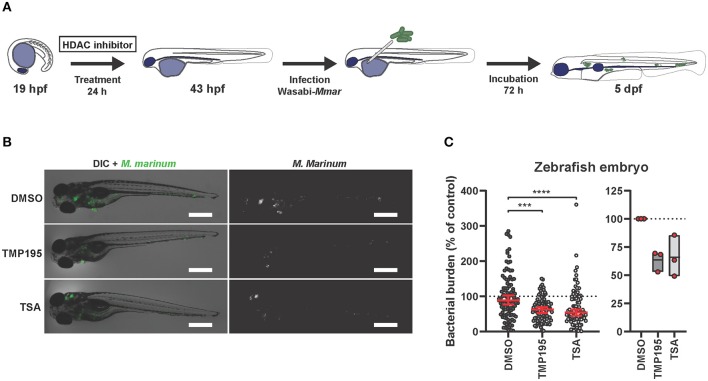
Zebrafish embryos exposed to HDAC inhibitors display reduced bacterial burden. (A) Outline of the experimental setup used in (B,C). (B) Zebrafish embryos were at the 20 somite stage [19 h post fertilization (hpf)], exposed to TMP195 (10 μM), TSA (30 nM), or DMSO at equal v/v for 24 h. Embryos were subsequently infected by microinjection of 250–300 CFU Mycobacterium marinum (Mmar) expressing Wasabi fluorescent protein, into the Duct of Cuvier. Shown are representative infected larvae of each treatment group imaged for Mmar fluorescence at 3 days post infection. Scale bar indicates 500 μm. (C) Indicated is bacterial burden of all zebrafish larvae (left) or each independent experiment (right). Graphs represent zebrafish larvae from different parent couples used in 3 independent experiments, and treated with TMP195 (n = 92), TSA (n = 90), or DMSO at equal v/v (n = 102) expressed as a percentage of the DMSO control. Each dot indicates an embryo with horizontal line and whiskers in red representing median with 95% confidence intervals (left) or each dot indicates the mean of a single experiment with floating bars representing min. to max. while the horizontal line represents the mean of the 3 independent experiments (***p < 0.001; ****p < 0.0001).